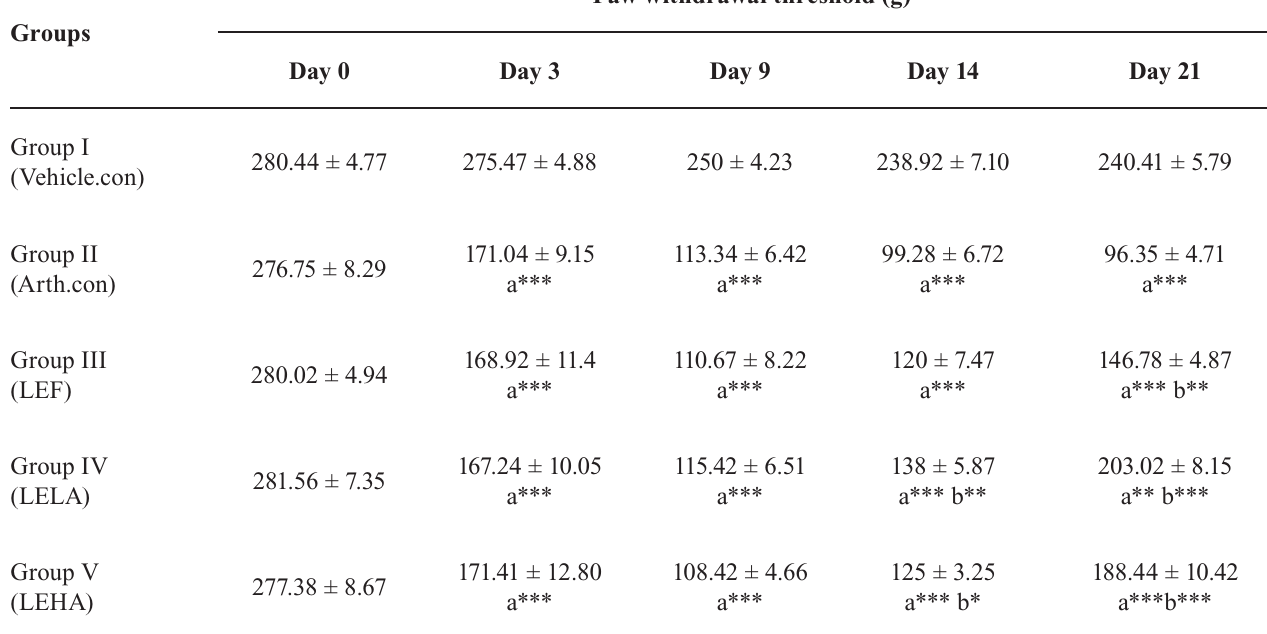
TABLE V- Ef fect of leflunomide and amitriptyline on mechanical hyperalgesia in the ipselateral paw